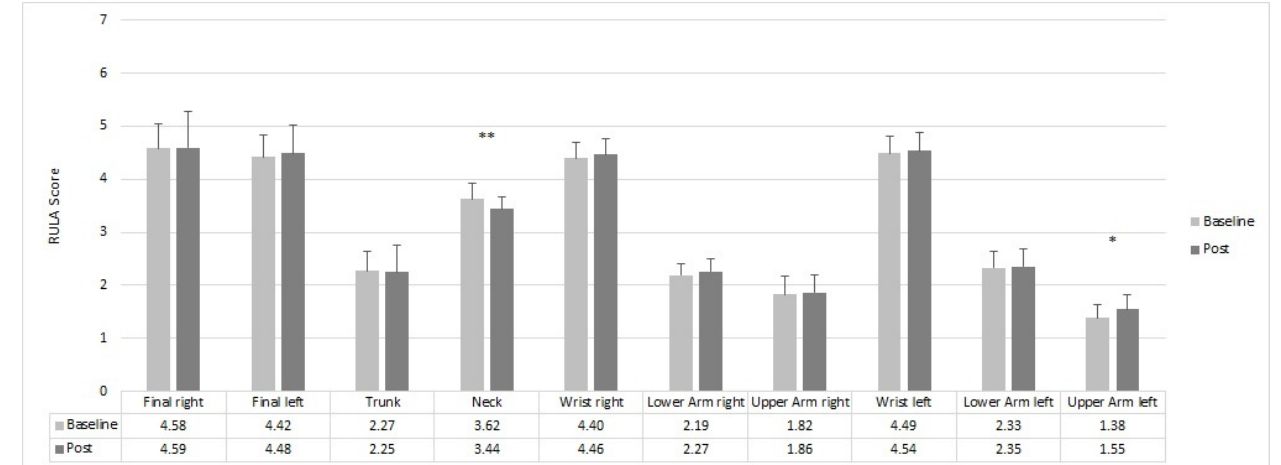
Figure 5. Effects of a 10-week resistance training on the body posture during dental treatment. Mean values for baseline and post-intervention for each body region are shown below. Significant differences are marked with asterisks: * p < 0.05 and ** p < 0.01.